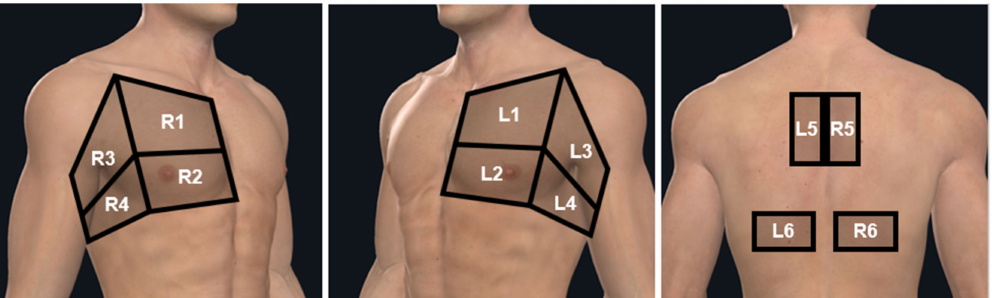
Figure 3. Graphical representation of the 12 scanned zones and the names used. “L” stands for left, “R” for right and the number identifies the zone (Source https://www.winfocus.org/ accessed 27 December 2021).